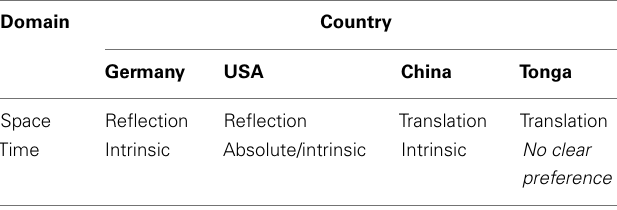
Table 2 | Most frequently adopted FoRs in the four investigated countries for space (Beller et al., under review) and time (Bender et al.,